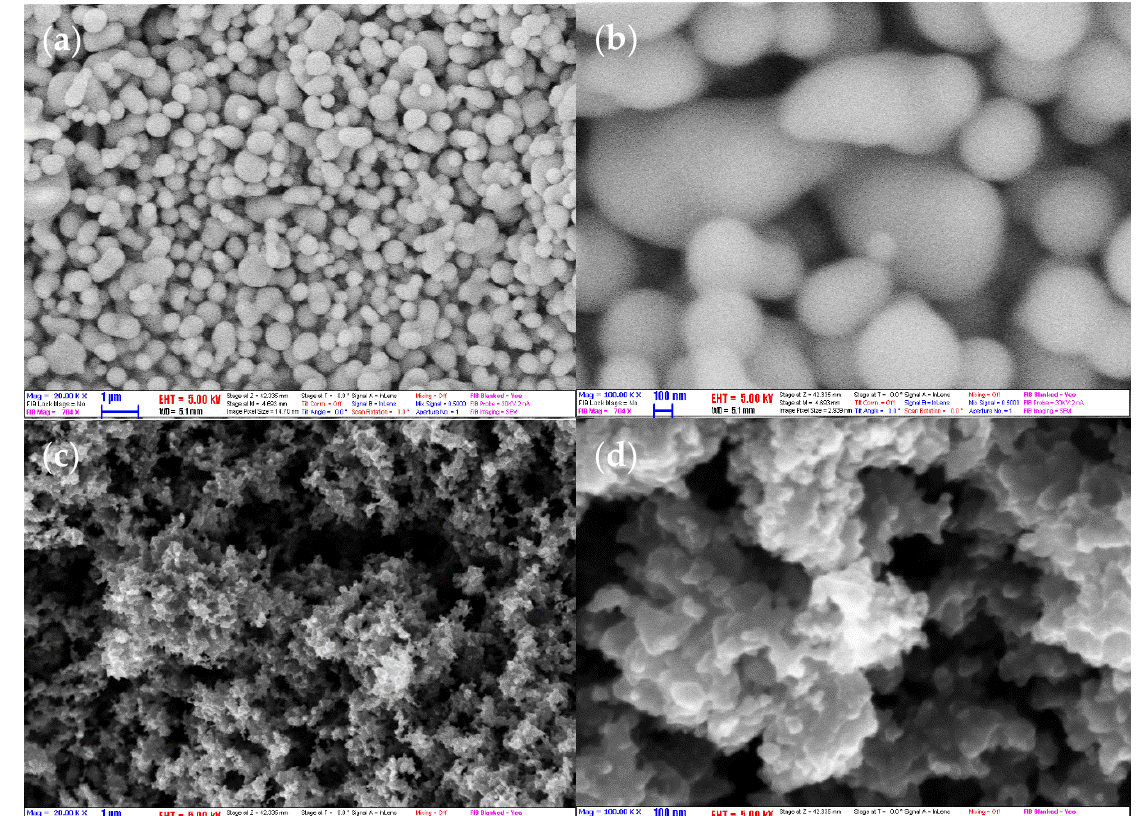
Figure 1. XRD pattern of ( a ) carbon nanosphere (CNS) and ( b ) carbon nanopowder (CNP) at the following XRD conditions: X-Ray: 40 kV, 30 mA. Scan speed: 3.0 degree/min.